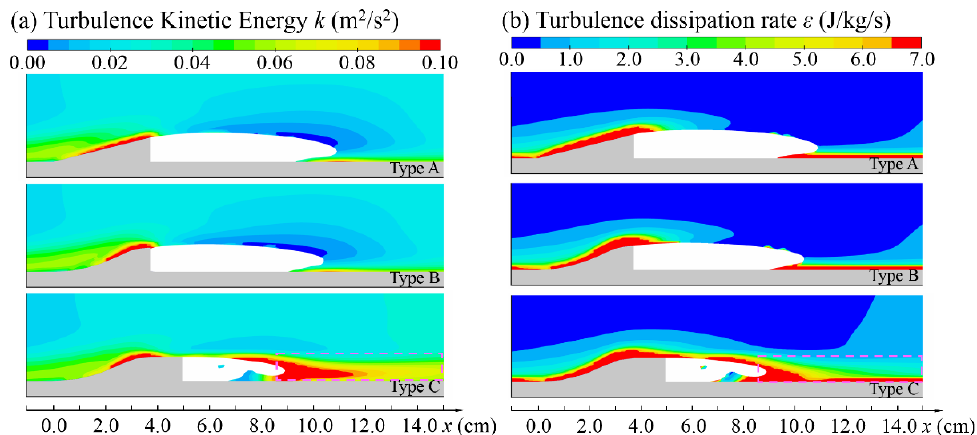
Figure 11. Horizontal distribution of ( a ) turbulent kinetic energy k ; ( b ) turbulence dissipation rate ε in deflector and cavity region at z = 1 cm.